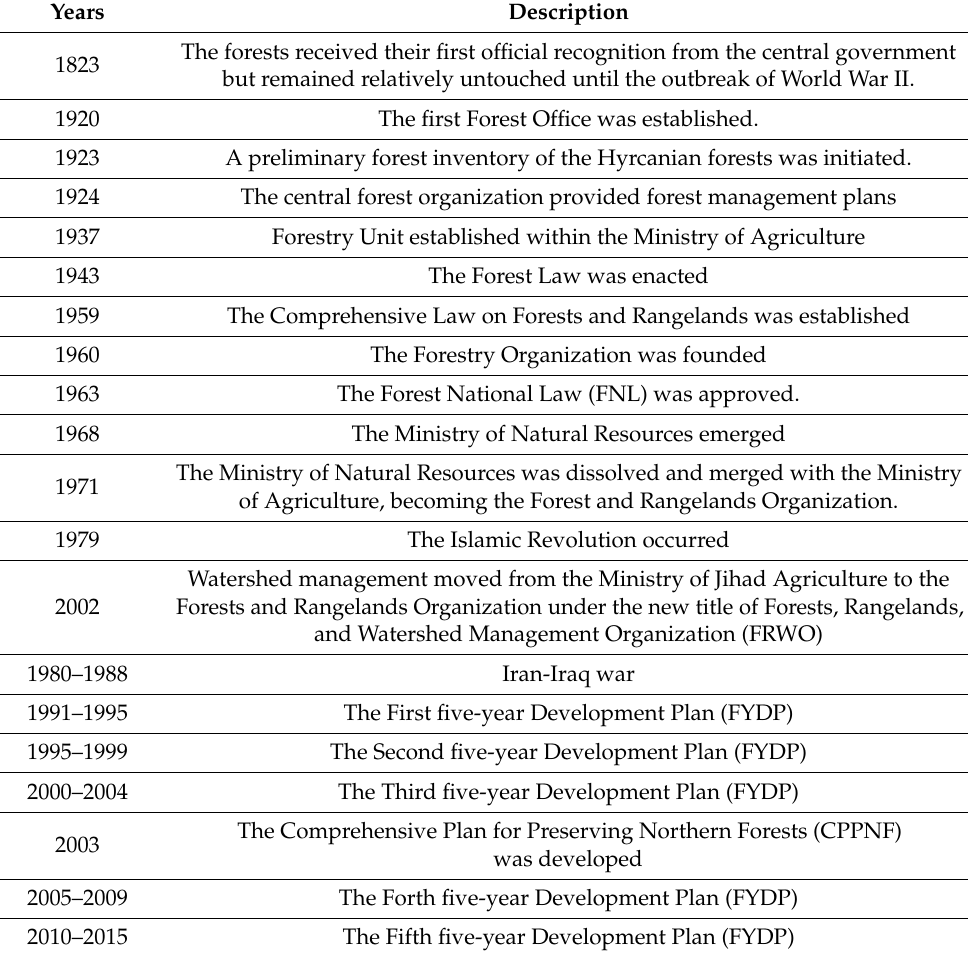
Table 1. The timeline for Hyrcanian forest policies over the last 200 years. Years